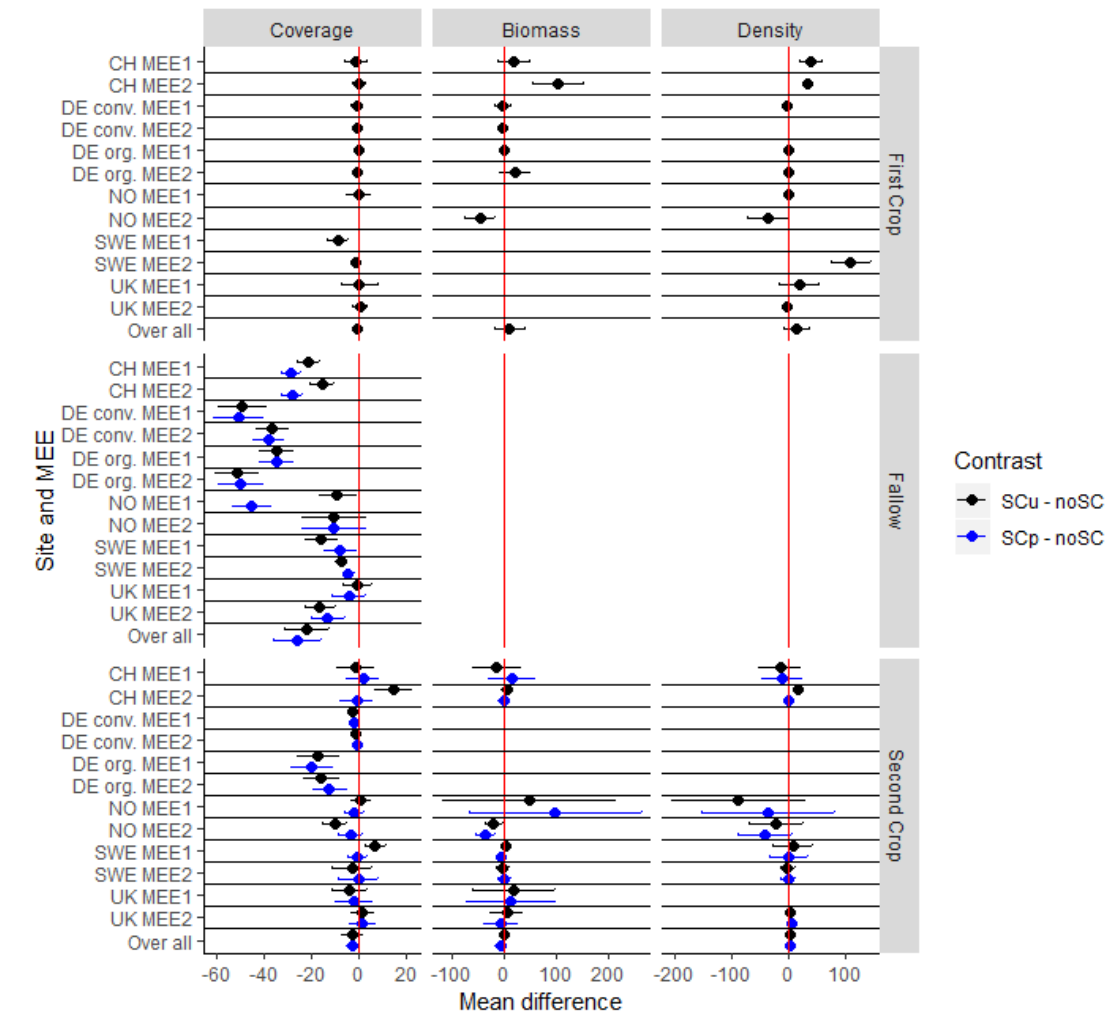
Figure 2. A meta-analysis of the e ff ect of the under-sown (SCu, black) and post-harvest sown subsidiary crops (SCp, blue) compared to no subsidiary crop cultivation (noSC) on the weed abundance. The e ff ects are shown for the three cropping periods (first crop, fallow, and second crop period). Values are given as mean di ff erences (MD). A negative e ff ect size represents a lower weed abundance, and a positive e ff ect size a higher weed abundance in subsidiary crop treatment. The points represent the estimated e ff ect and the lines the corresponding 95% confidence interval. Weed coverage is given in %-ground coverage, biomass in g m − 2 , and density in plants m − 2 . (MEE1 / MEE2 = first / second round of the multi-environmental